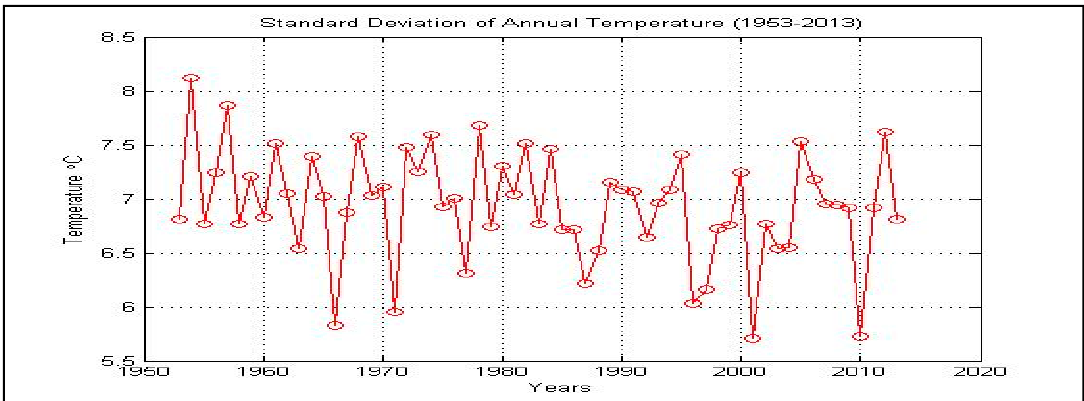
Figure 15. Standard Deviation on Temperature of Abbottabad 1953–2013.